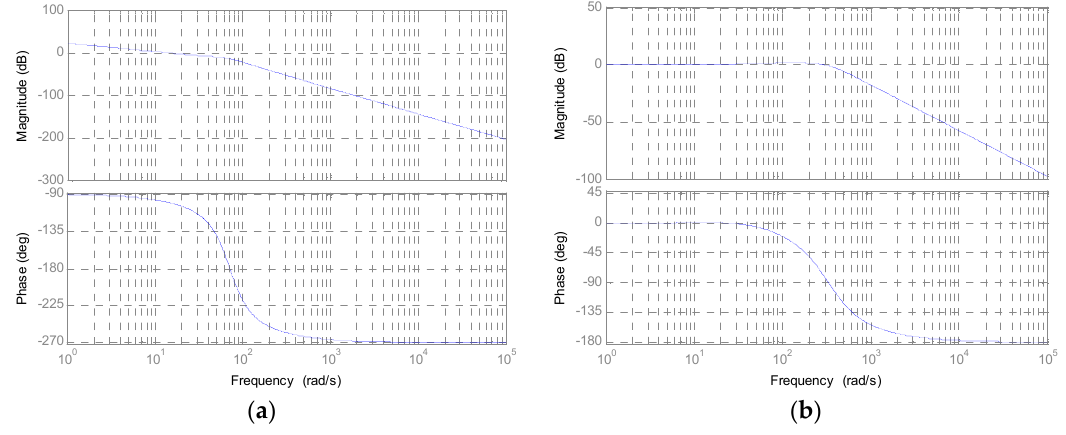
Figure 15. ( a ) Open loop frequency response of the direct drive actuator; ( b ) Closed loop frequency response of the direct drive actuator.